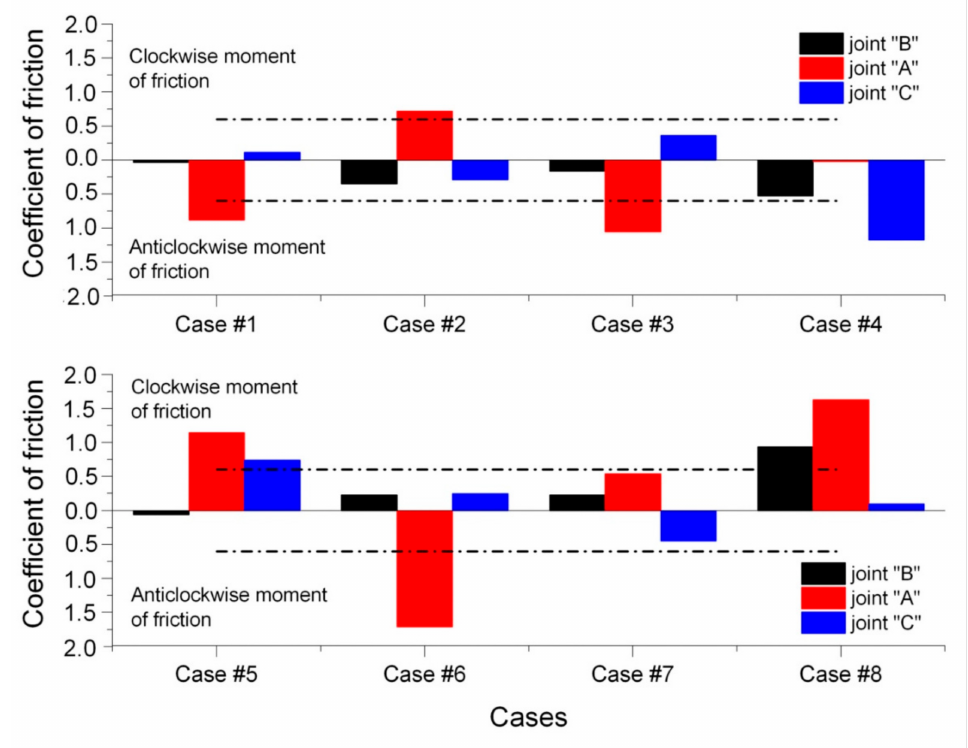
Figure 18. Coefficient of friction for cases #1 to #8 of non-uniform strain distribution (the level µ = 0.6 assumed in the design is marked by the dash-dotted